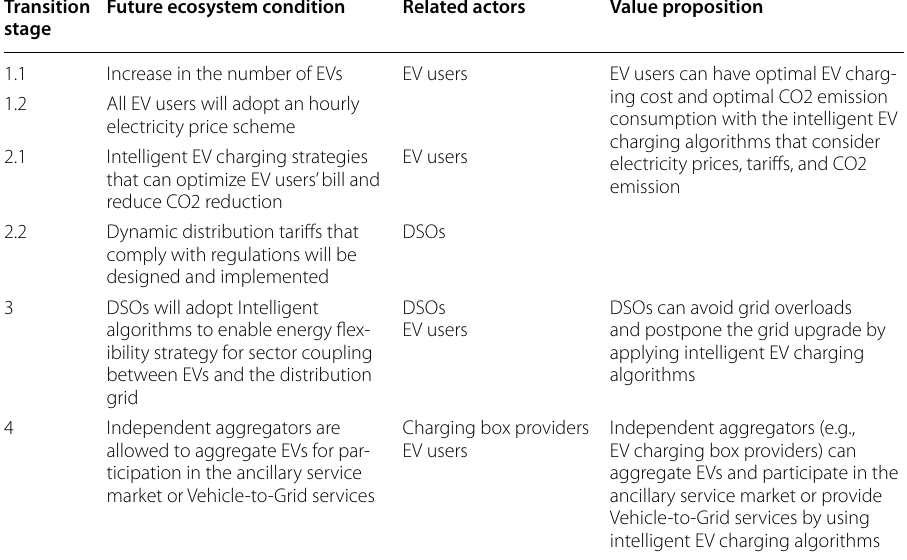
Table 25 The future ecosystem description and the proposed value propositions for each transition stage Transition